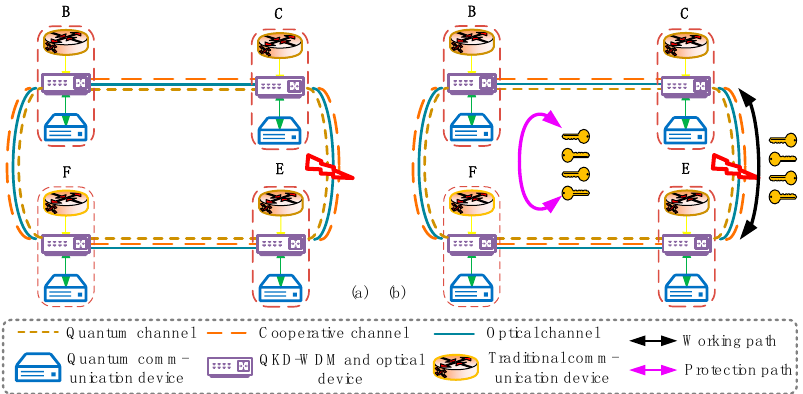
Figure 9. The protection in QKD networks, ( a ) a link failure occurred in the network, ( b ) the protection in the network.